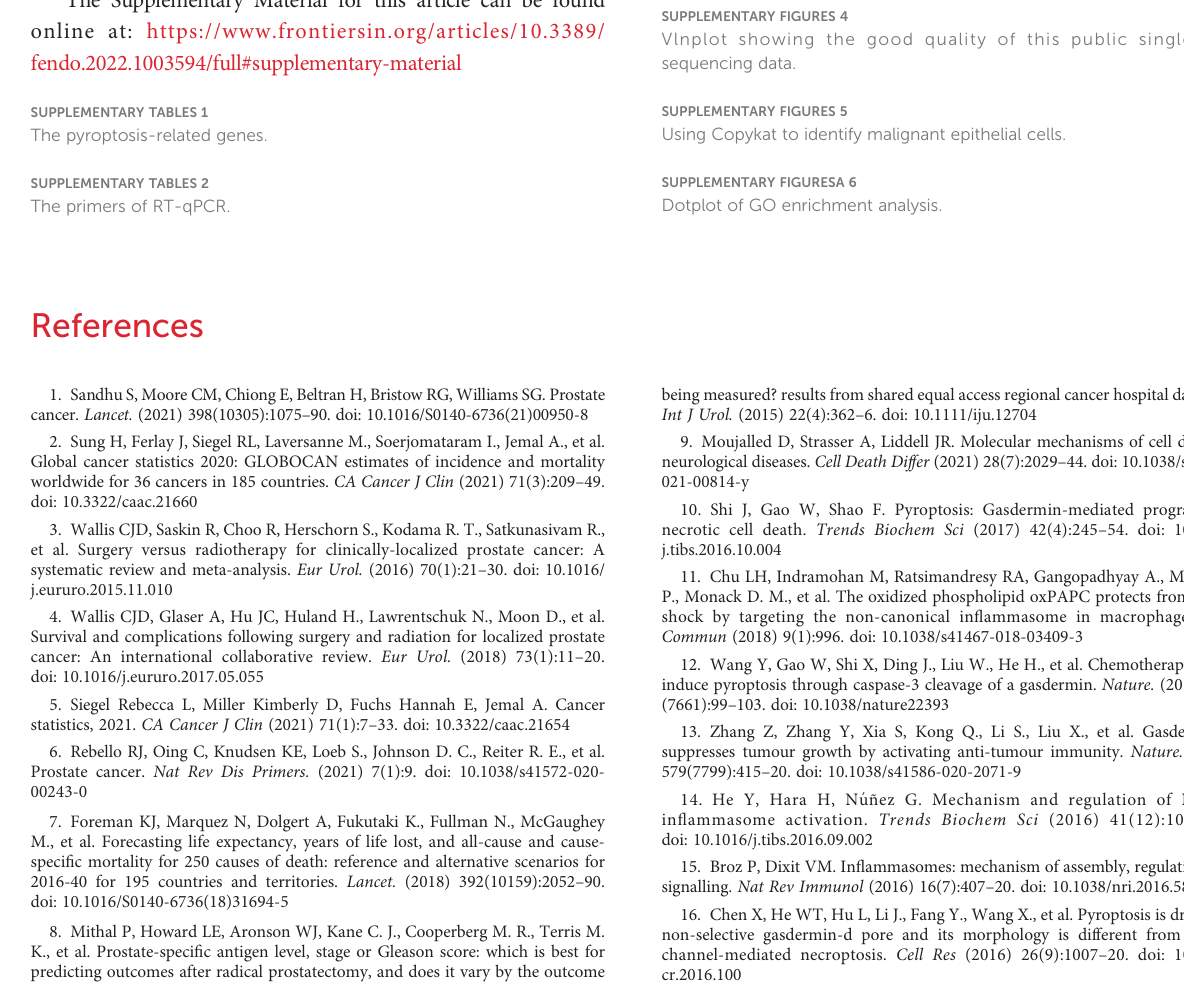
down-regulated in Class 1).